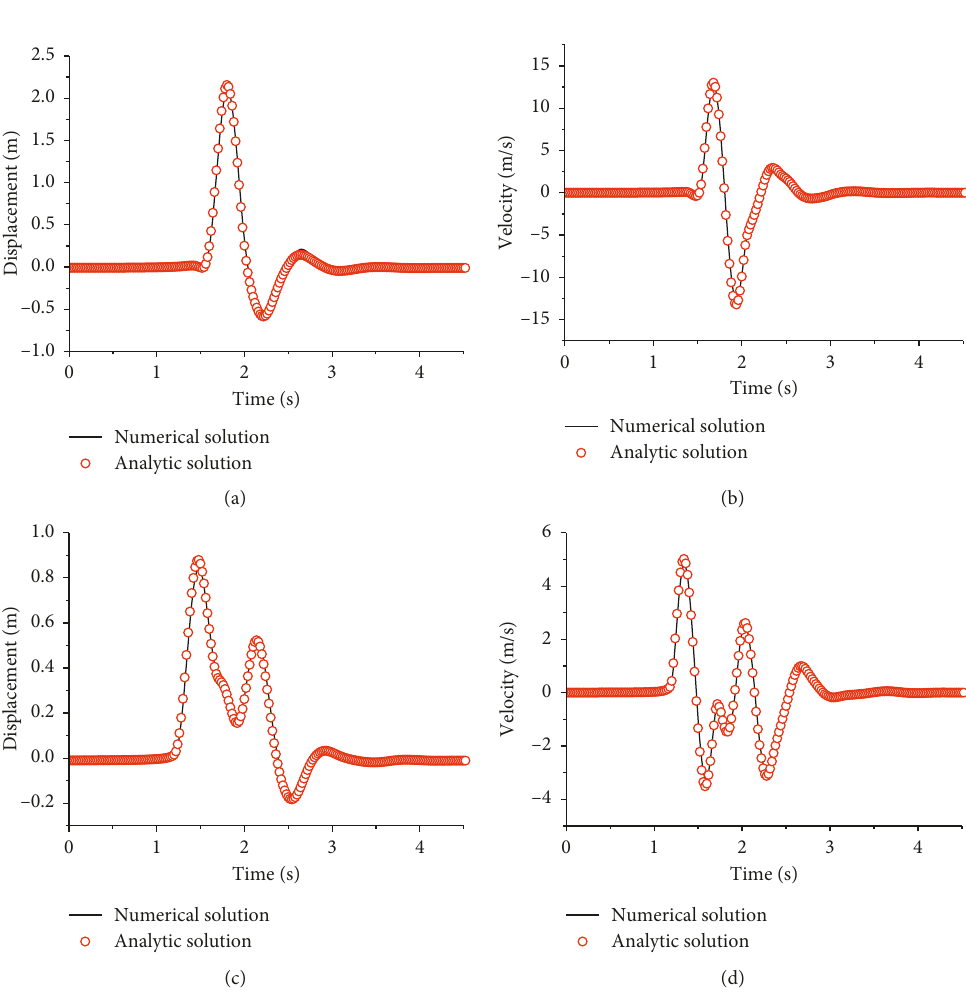
Figure 4: Displacement and velocity time curve of each node under incident angle (60 ° , 30 ° ). (a) Displacement of point A; (b) velocity of point A; (c) displacement of point B; (d) velocity of point B.